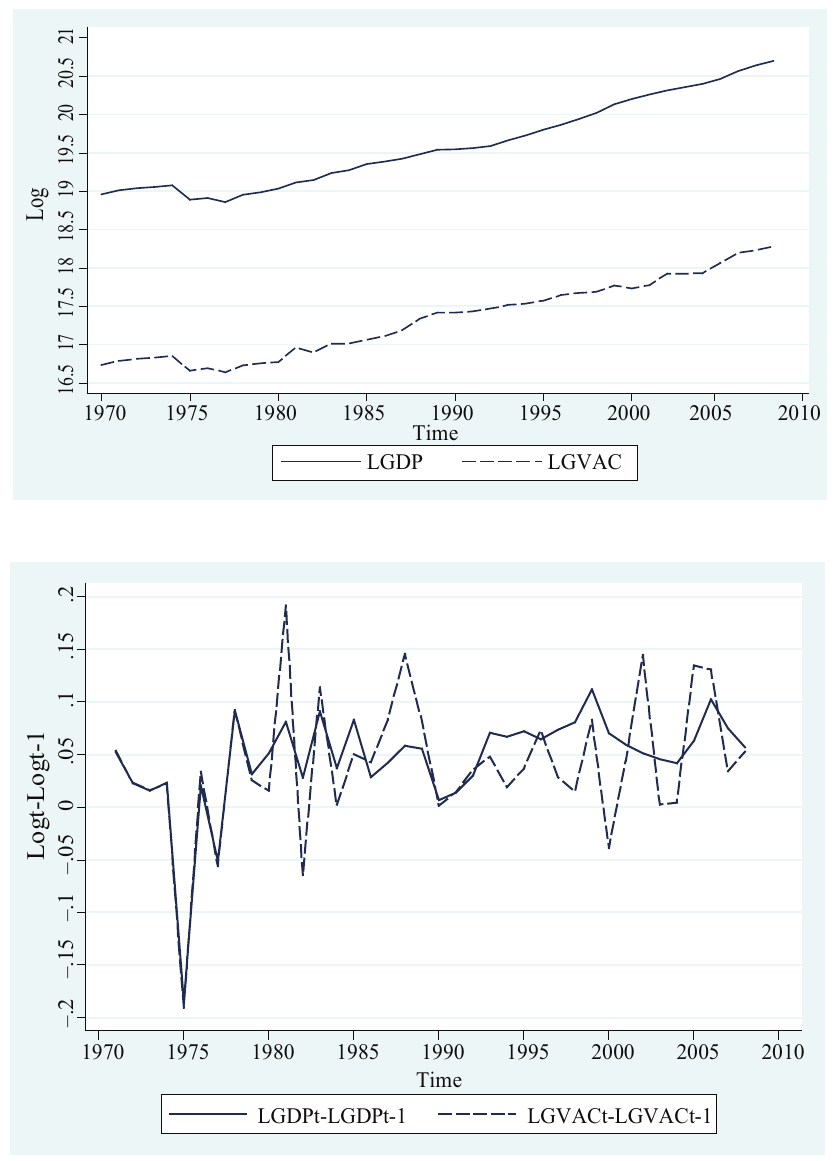
figure 3. Evolution of GDP and construction flows in Cape Verde, over time, in levels and in